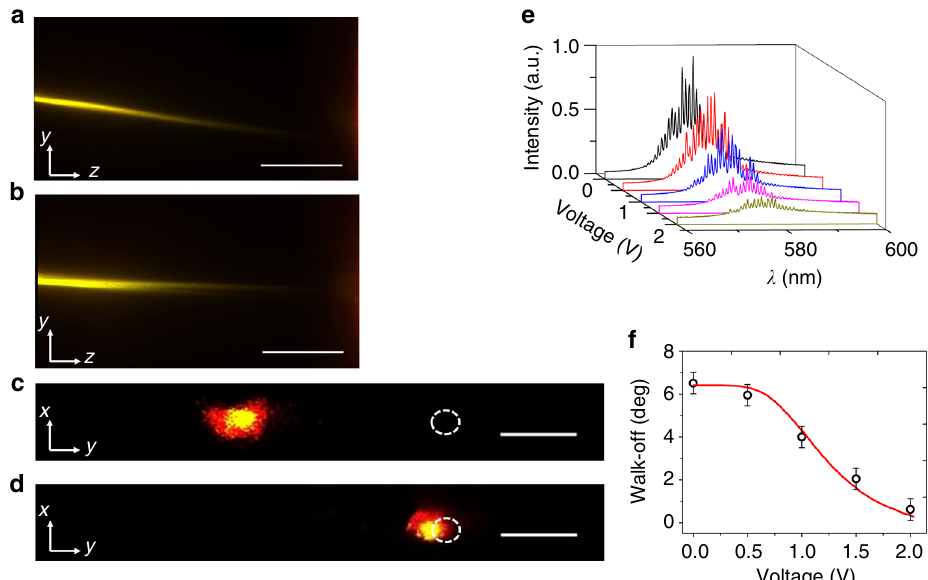
Fig. 5 Controlled steering of soliton-assisted random laser emission. a Random lasing within a 5 mW near-infrared soliton, with walk-off at 7° in the plane yz in the absence of voltage bias. b Random lasing within a 5 mW near-infrared soliton, with vanishing walk-off at a bias V = 2 V. The scale bars in a and b indicate a length of 500 μ m. c Output random laser spot in xy for V = 0 V, corresponding to a . d Output random laser spot in xy for V = 2 V, corresponding to b ; the white dashed circles in c and d indicate the direction of the input wave-vector, the scale bars correspond to 100 μ m. e Random laser emission spectra acquired at the 5 mW nematicon output for various applied voltages. f Measured (symbols with error bars, s.d.) and calculated (solid line) walk-off versus applied voltage (see Eq. (5) in the Methods). The error bars (in s.d. units) are computed over 25 acquisitions and the pump energy per pulse is well above